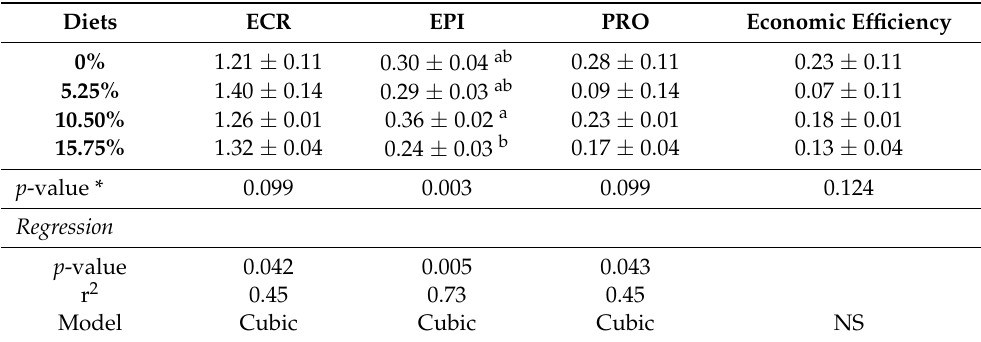
Table 7. Economic analysis of feeds with the different inclusion levels of full-fat BSFL meal in the